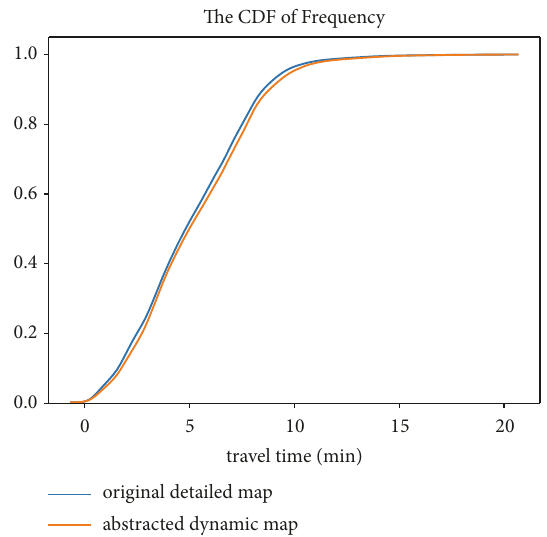
Figure 13: The CDF of travel time frequency in original detailed map and abstracted dynamic map.